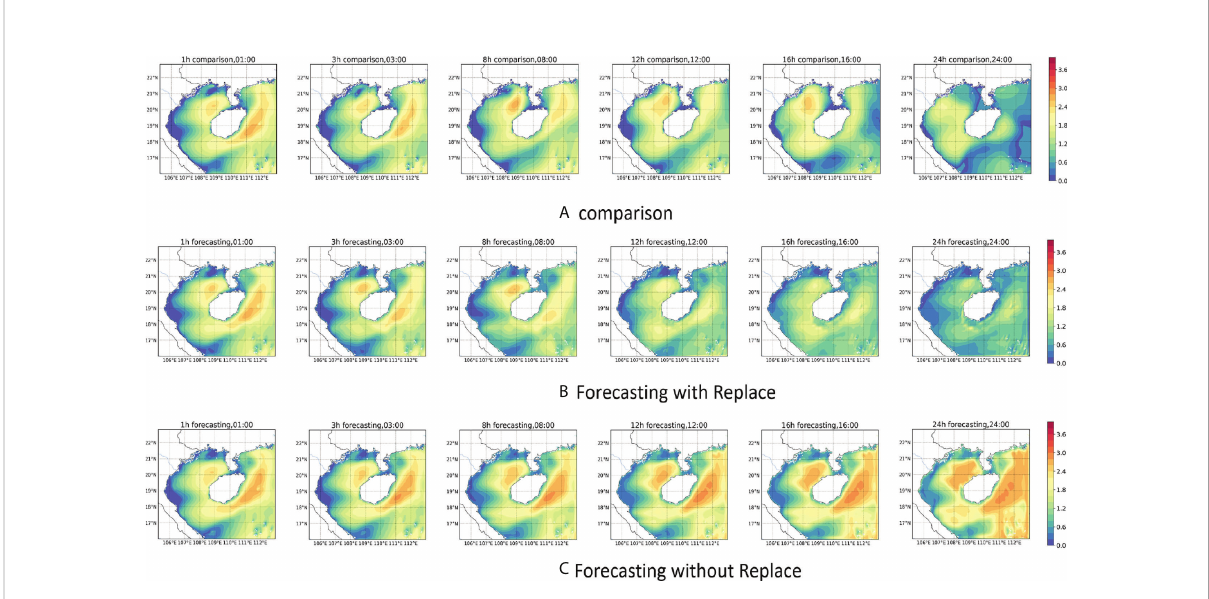
FIGURE 14 24-hour forecast results of signi fi cant wave height. (A) is the signi fi cant wave height diagram of the numerical model. (B) is the predicted signi fi cant wave height diagram after Replace mechanism is adopted in the model. (C) is the predicted signi fi cant wave height diagram without Replace mechanism.